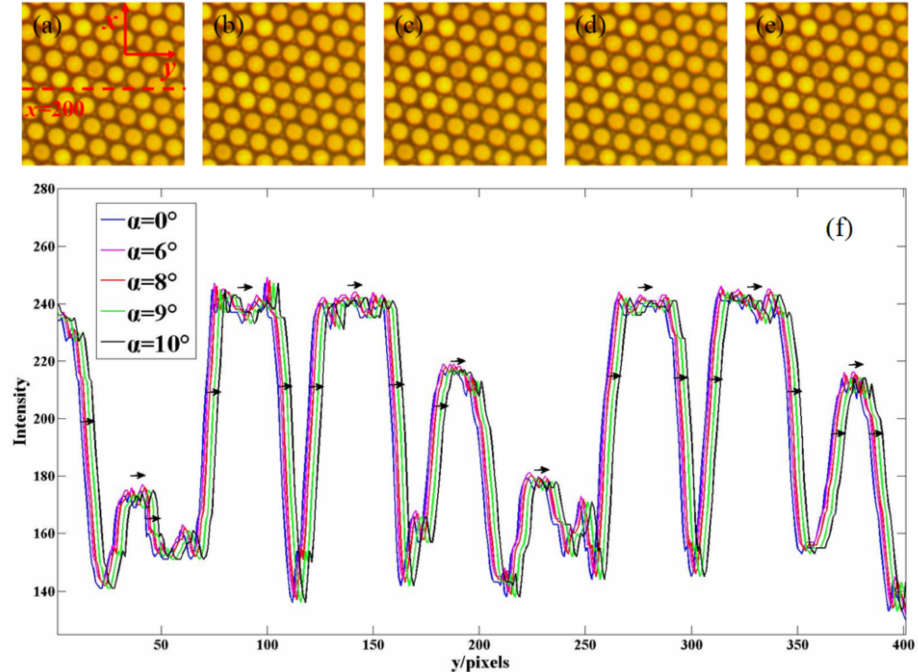
Figure 5. Experimental images: ( a ) original image ( α = 0 ◦ ); ( b ) α = 6 ◦ ; ( c ) α = 8 ◦ ; ( d ) α = 9 ◦ ; ( e ) α = 10 ◦ ; ( f ) intensity distributions of ( a , e ) at x = 200, y direction.